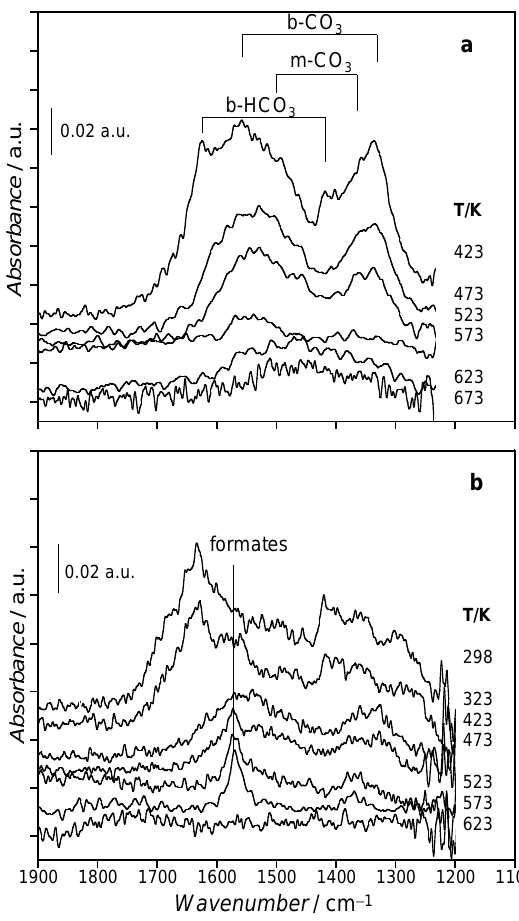
Figure 16. In situ FTIR spectra of surface species during activation treatments on 4.8NiO/Z hy catalyst precursor. Spectra recorded in O 2 /N 2 oxidative flow ( a ), and in H 2 /N 2 reductive flow ( b ) at increasing temperature.